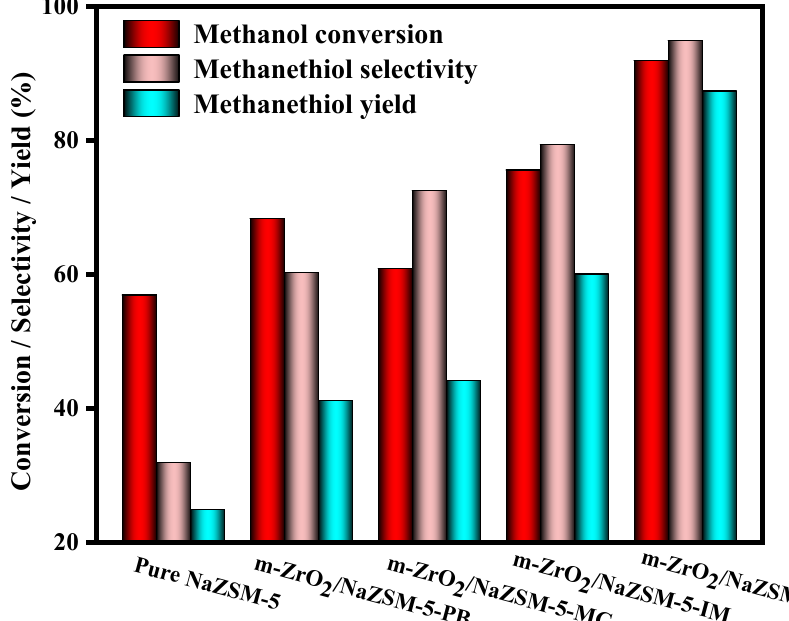
Figure 8. Catalytic performance of different composite catalysts.